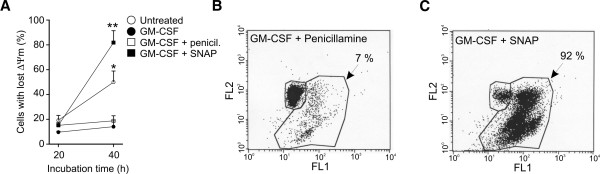
SNAP induces late loss of ΔΨm. Eosinophils were incubated with solvent, SNAP (1 mM), penicillamine (1 mM) and/or GM-CSF (10 pM) for indicated times (A) or for 40 hours (B-C) after which JC-1-staining and analysis of mitochondrial membrane potential by flow cytometer was conducted as described in materials and methods. In A shown are mean ± SEM from five independent experiments. * indicates p < 0.05 and ** p < 0.01 when compared to cells treated with GM-CSF or GM-CSF and penicillamine, respectively. In B-C shown are representative graphs from analysis of ΔΨm with percentages of cells with lost ΔΨm.